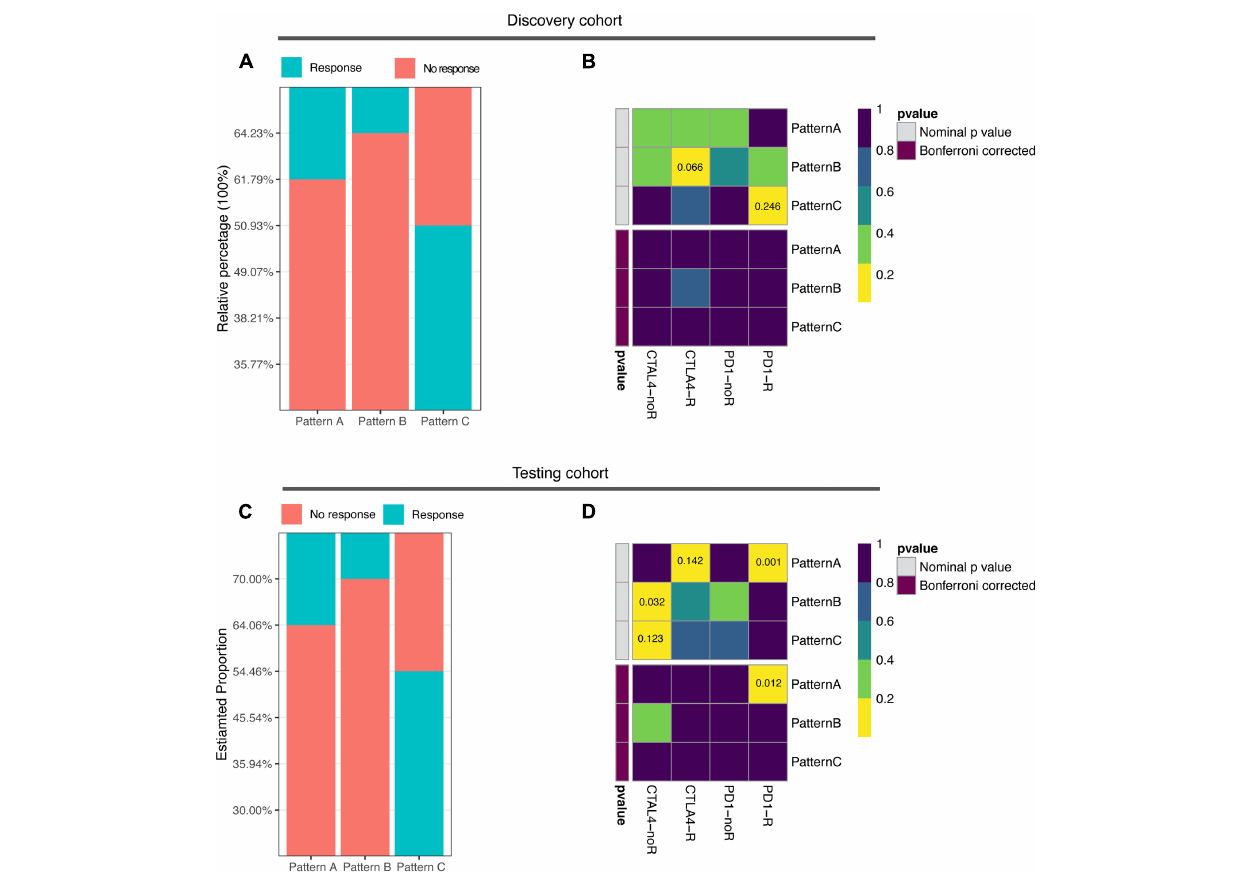
FIGURE 4 | Correlation of ubiquitin patterns with immunotherapy benefit. (A,C) The predicted response rate in TIDE analysis of discovery and testing cohorts. Fisher’s exact test, p = 0.008, p < 0.0001, respectively. (B,D) The similarity of gene expression profiles between ubiquitin patterns and melanoma patients treated with ICB ( n = 47). CTLA4-noR, patients no respond to anti-CTLA4 treatment, CTLA4-R, patients respond to anti-CTLA4 treatment, PD1-noR, patients no respond to anti-PD1 treatment, PD1-R, patients respond to anti-PD1 treatment.